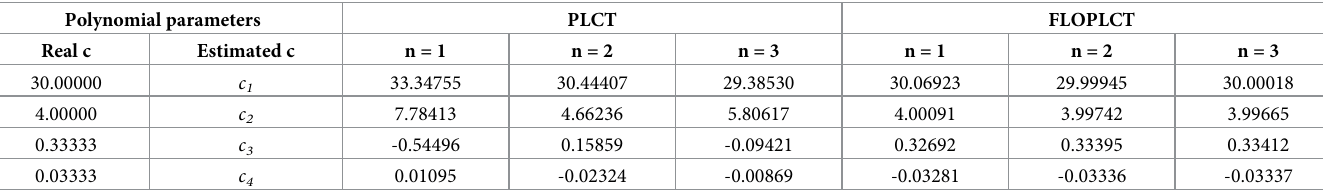
Table 3. The estimated polynomial parameters of the PLCT and FLOPLCT methods in α stable distribution noise environment ( MSNR = 16 dB , α = 0.8). Polynomial parameters PLCT FLOPLCT Real c Estimated